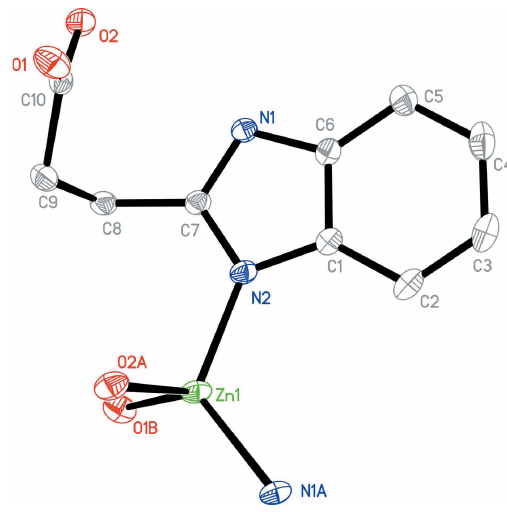
Figure 1 The asymmetric unit of 1 , with additional symmetry-related atoms. The